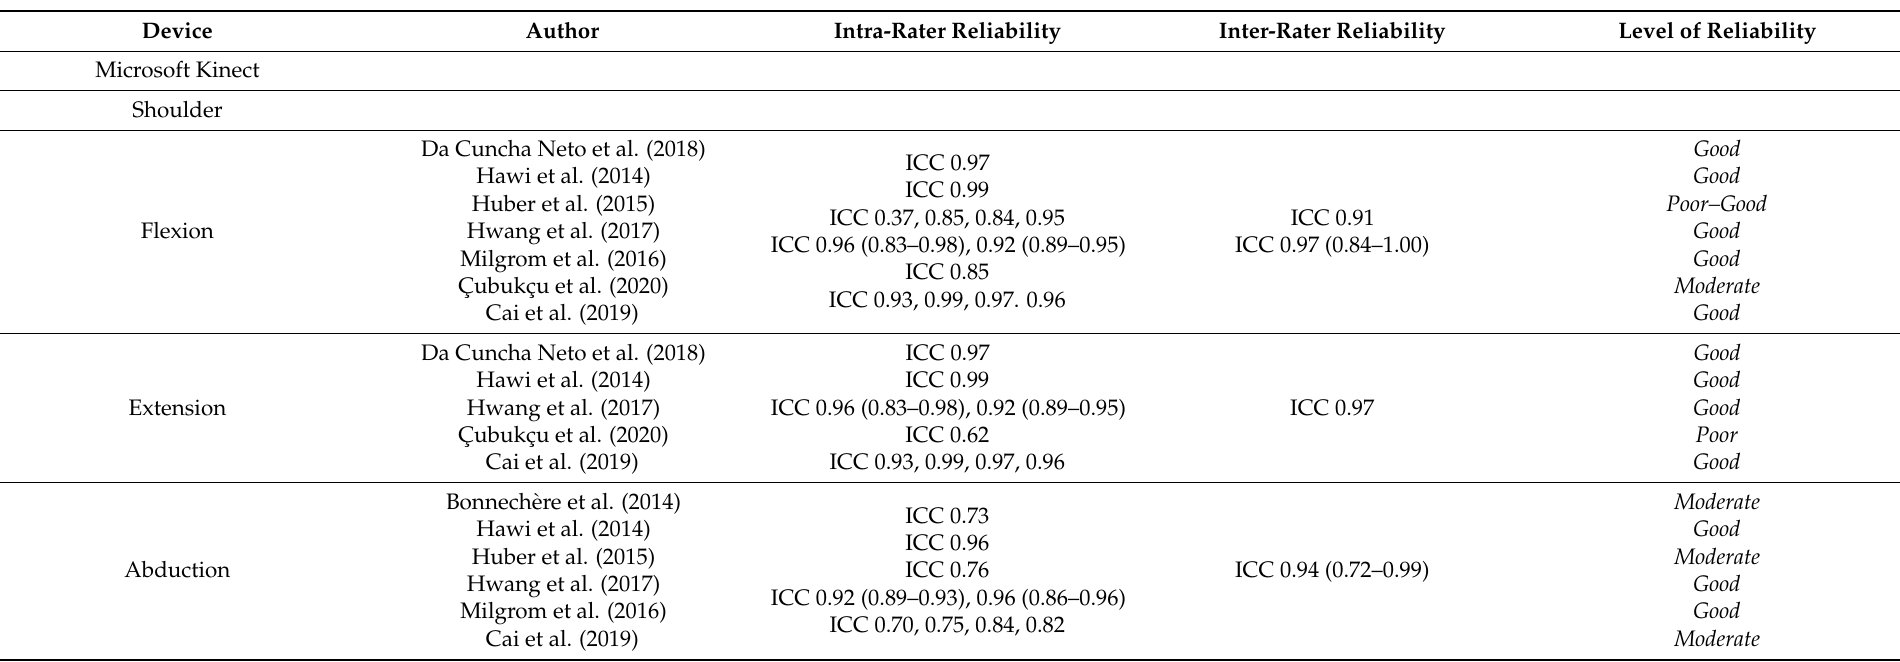
Table 2. Intra-rater and Inter-rater reliability (95% CI) for measurement of shoulder range of motion by device and movement